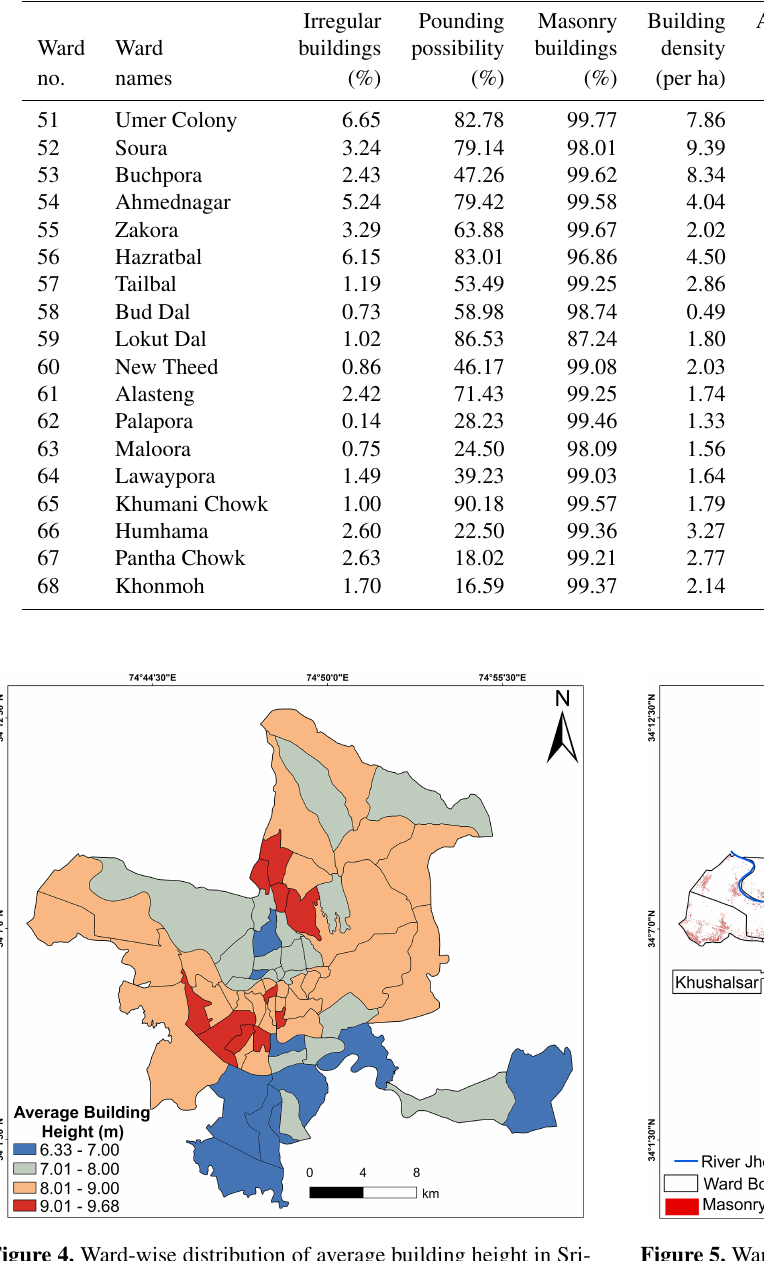
Figure 5. Ward-wise distribution of masonry buildings in the